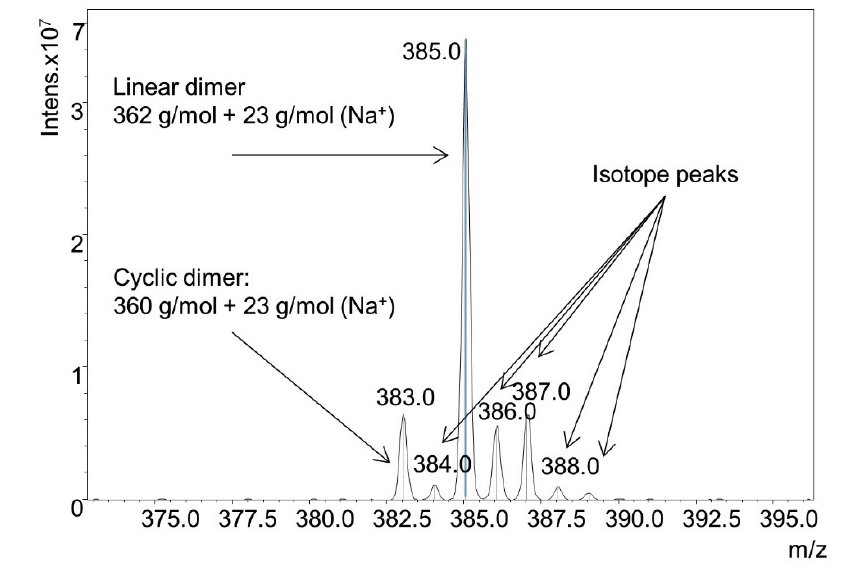
Figure 10. Detail of ESI-MS spectrum from solution synthesis of cyclic